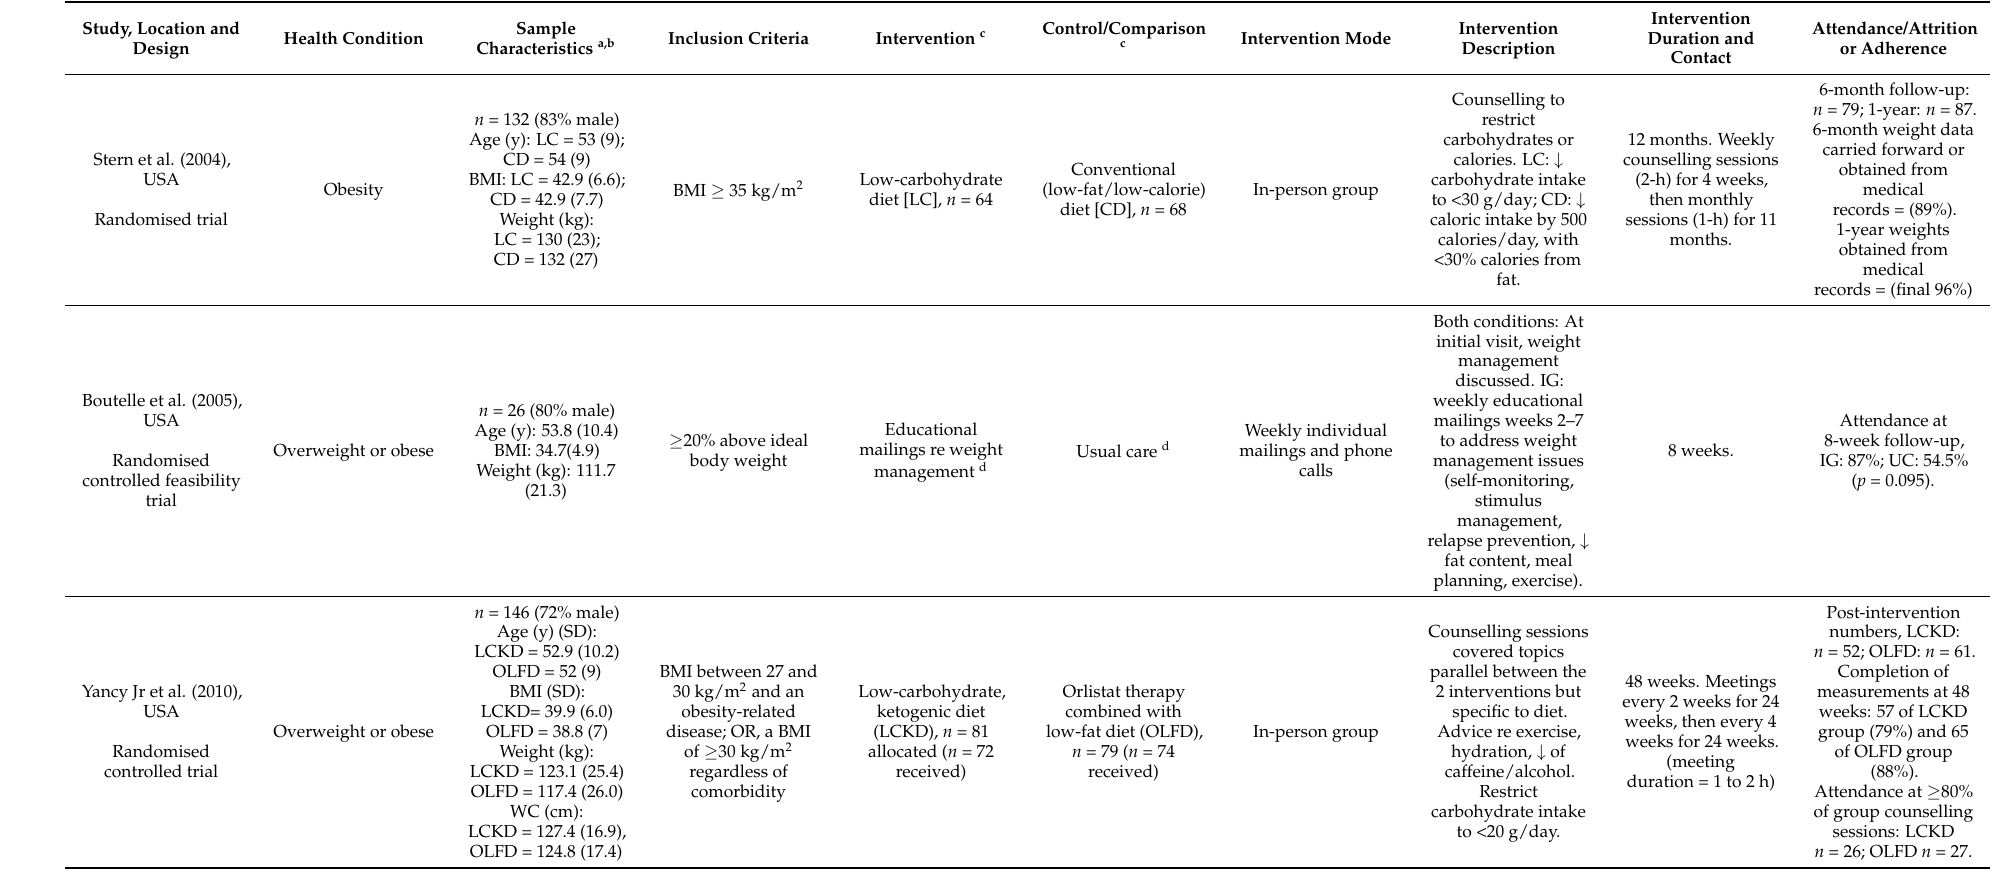
Table 3. Characteristics of the included studies, grouped and listed in order of health condition discussed in